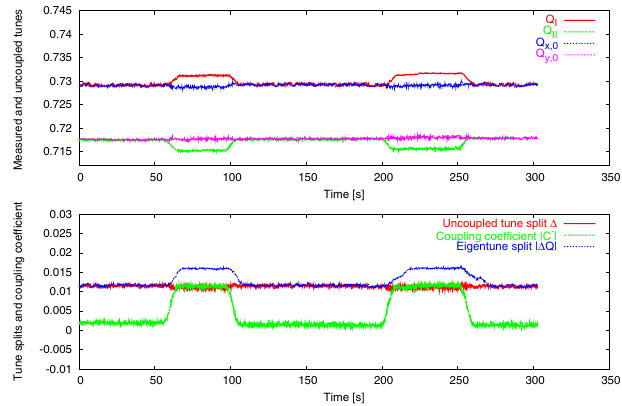
FIG. 5. (Color) The fractional tune splits and the coupling coefficient.